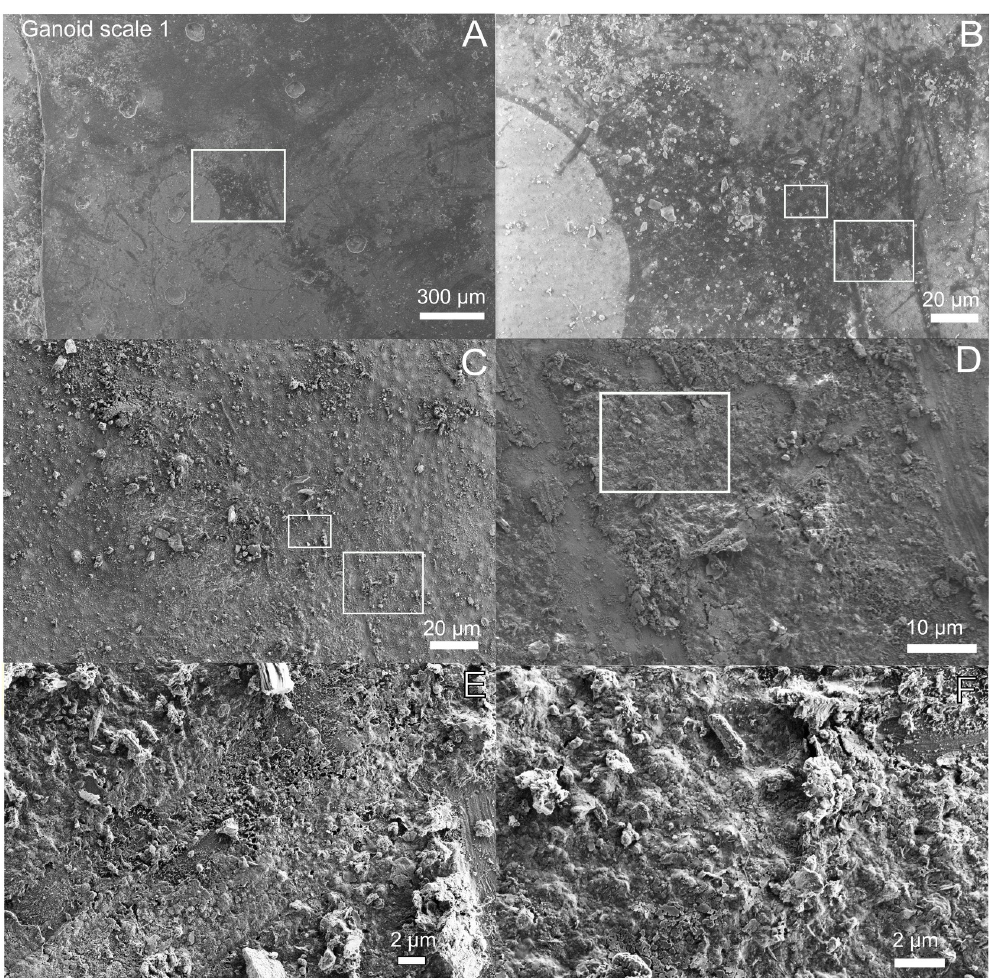
Fig 6. Ultrastructure of gray-brown film on Messel fossil fish scale. A) Low-vacuum SEM image showing gray-brown film on ganoid scale 1. The film appears darker than the rest of scale. Note that the ganoid scale is rotated compared with Figs 1, 2 and 4A. B) Zoom-in of white square in A. C) Same area as in B but in high-vacuum mode. D) Zoom-in of right white square in C. E) Zoom-in of left white square in C. F) Zoom-in of white square in